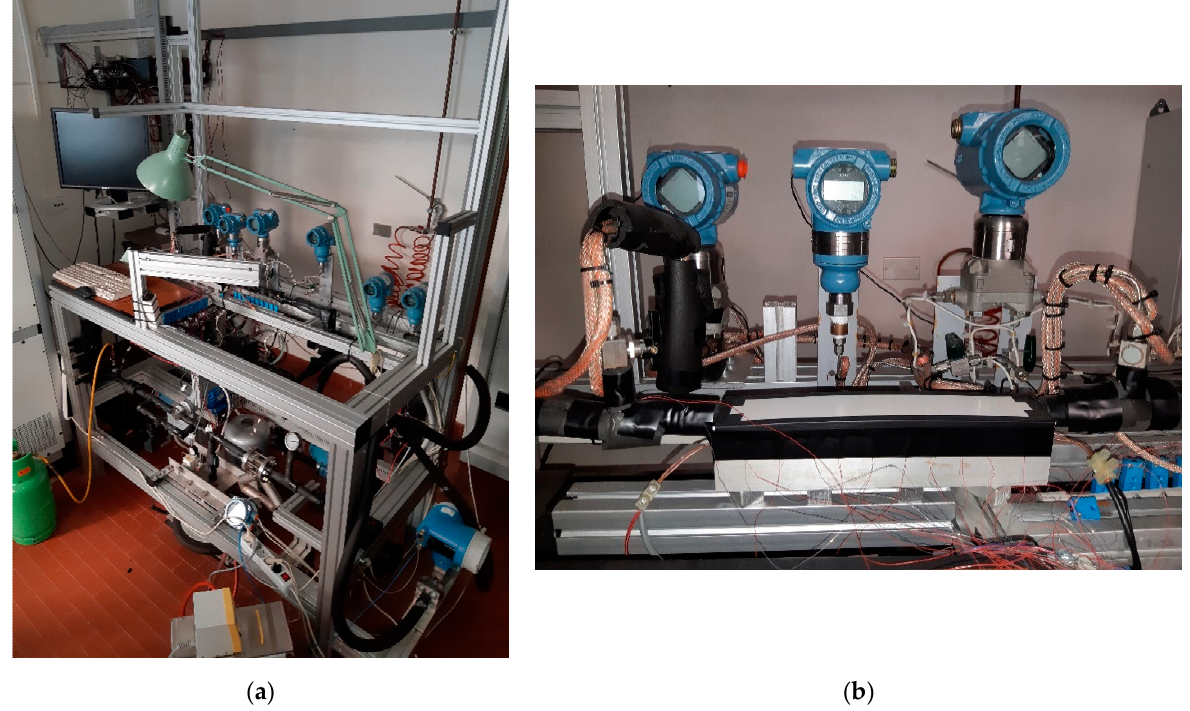
Figure 2. ( a ) Picture of the test facility; ( b ) picture of the test section.